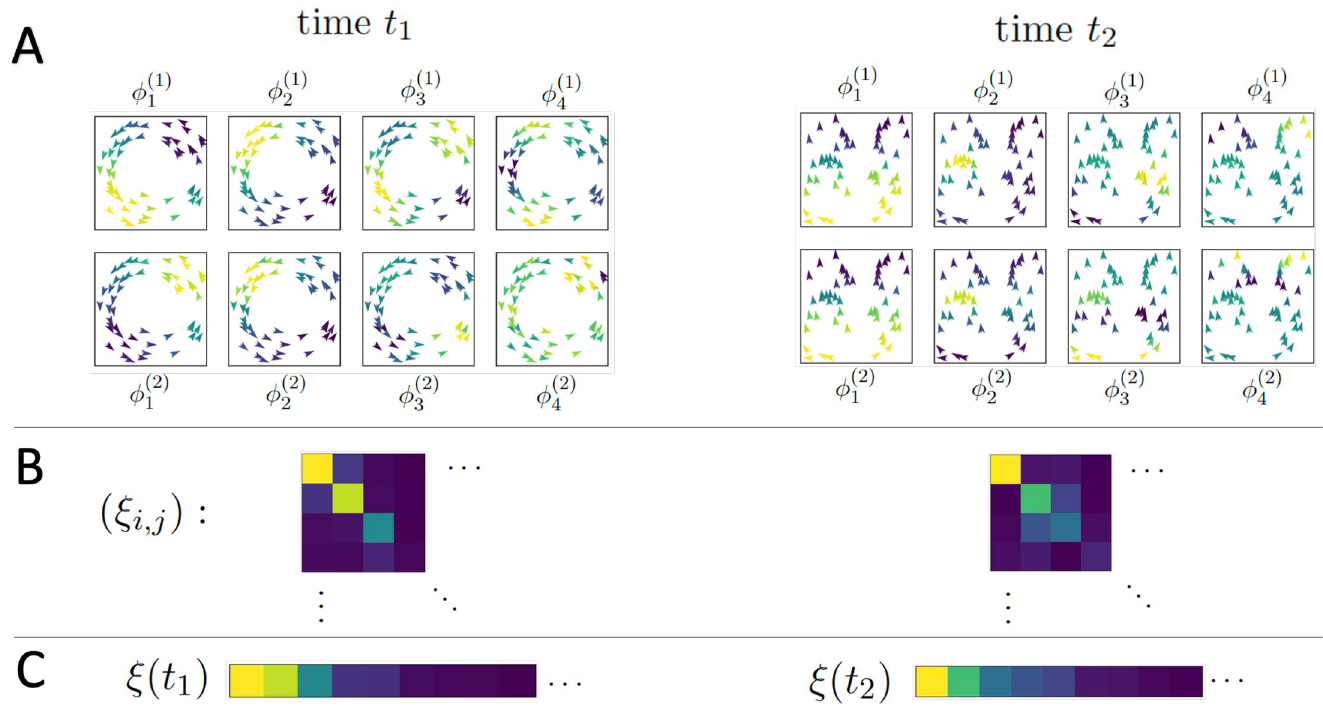
Fig 3. A toy system of 50 agents; the left and right sides of the figure represent observations of the system at two different times when the system is in two different organized states. (A) Agents in each subpanel are colored by the indicated diffusion coordinate, (B) A color plot of the matrix ( ξ i , j ) with yellow indicating larger values, blue indicating smaller values, (C) The values of the above inner product matrix, ordered by absolute magnitude; these are the vectors used to classify the system’s regimes.